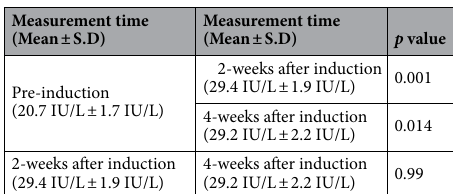
Measurement time (Mean ± S.D)